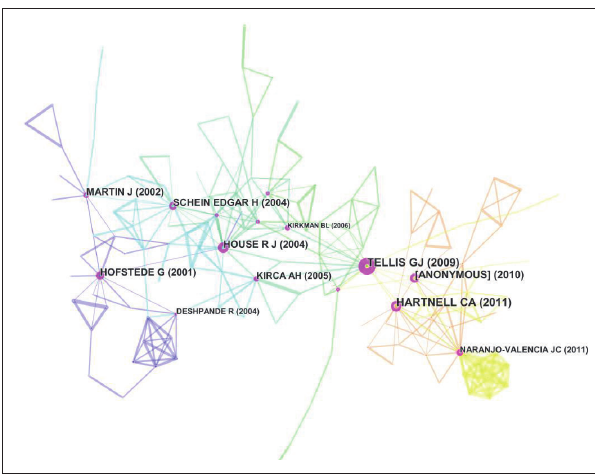
FIGURE 8: Map of references: Cluster view.